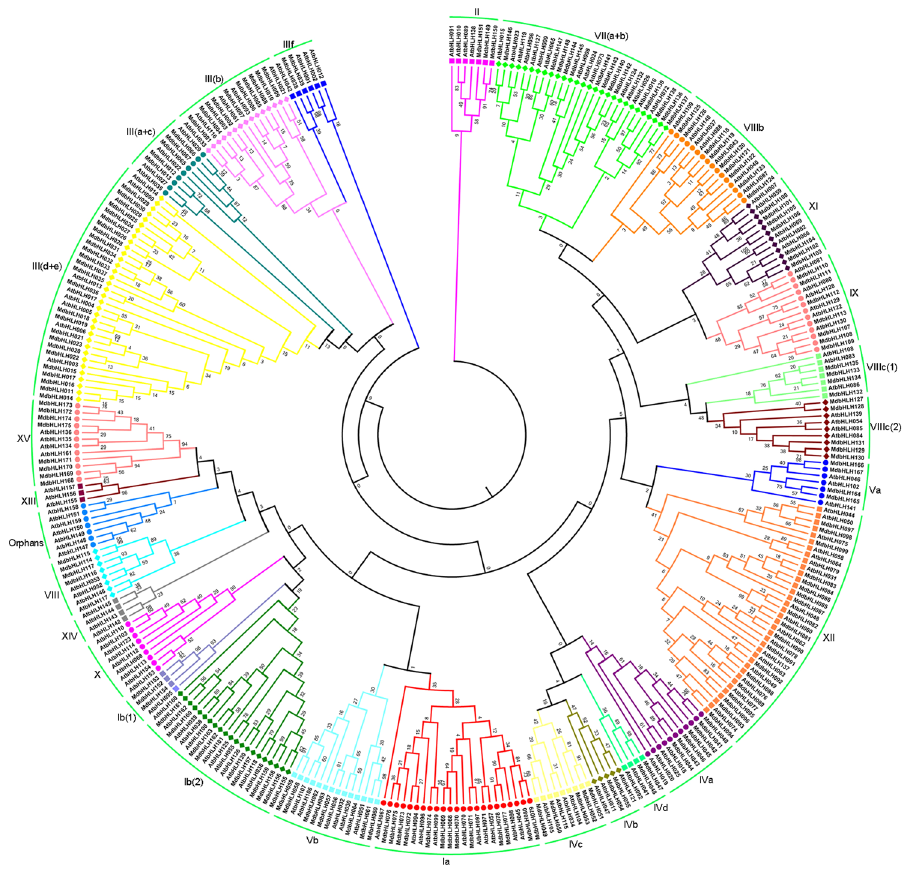
Figure 2. Phylogenetic tree based on apple and Arabidopsis bHLH transcription factors. The phylogenetic tree was generated with CLUSTALW and using the neighbor-joining method. The phylogenetic tree was inferred using MEGA 5.0 software. Reliability of the predicted tree was tested using bootstrapping with 1000 replicates. Numbers at the nodes indicate how often the group to the right appeared among bootstrap replicates. Branch lines of subtrees are colored indicating different bHLH subgroups. Apple and Arabidopsis bHLH genes in the same subgroup are denoted by squares ( □ ), circles ( ○ ), triangles ( Δ ) and diamonds ( ◇ ) in various colors